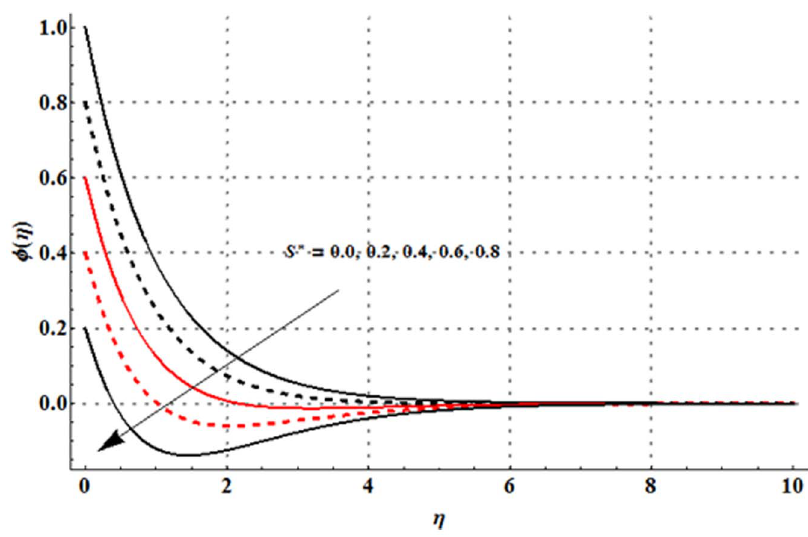
Figure 19. Influence of S (cid:2) on the concentration profile w ( g ) when M ~ 0 : 6, b ~ 0 : 4 ~ Rd , l 1 ~ 0 : 5, l ~ 0 : 3 ~ N , Pr ~ 1 : 2, S ~ 0 : 2 and Sc ~ 1 : 0 :